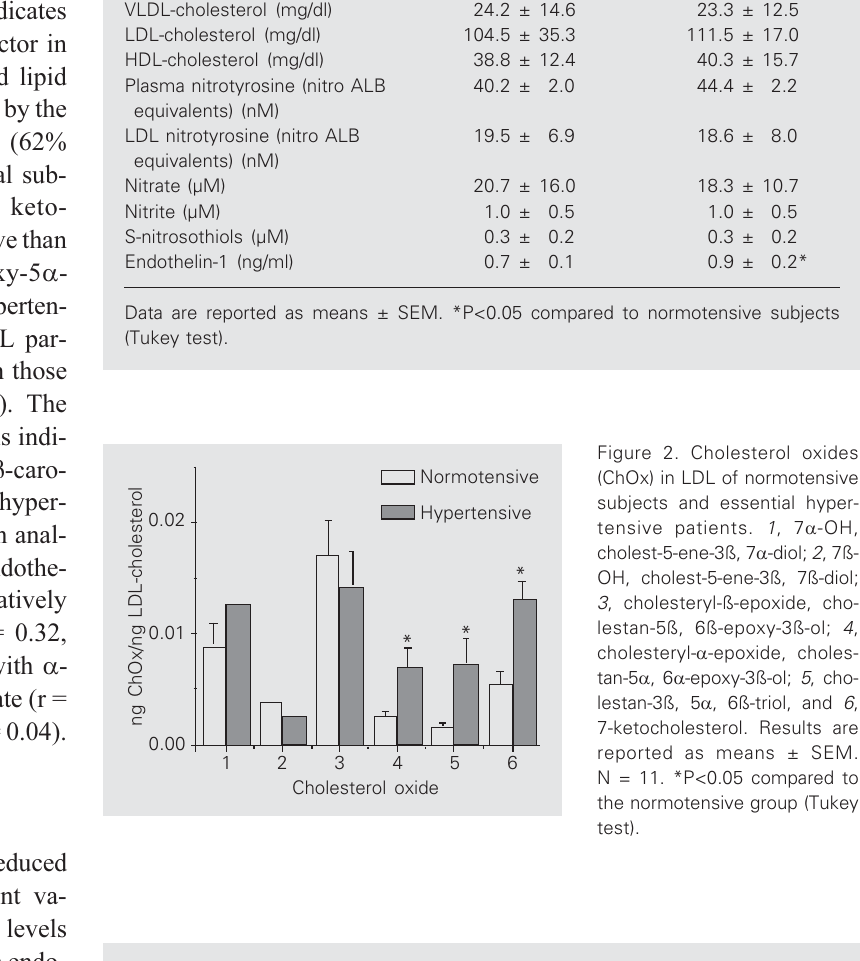
Table 2. Antioxidants in plasma of patients with essential hypertension and normoten- sive